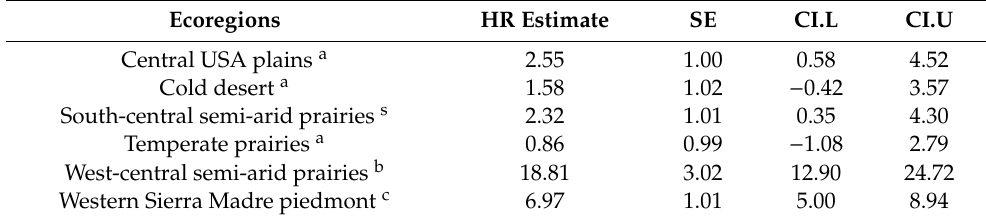
Table 3. Raw mean home range estimates with standard error (SE) and 95% confidence intervals (CI.L and CI.U) for all T. ornata studies by ecoregion. Superscript letters show di ff erences among ecoregions, based on Holm–Bonferroni pairwise post hoc